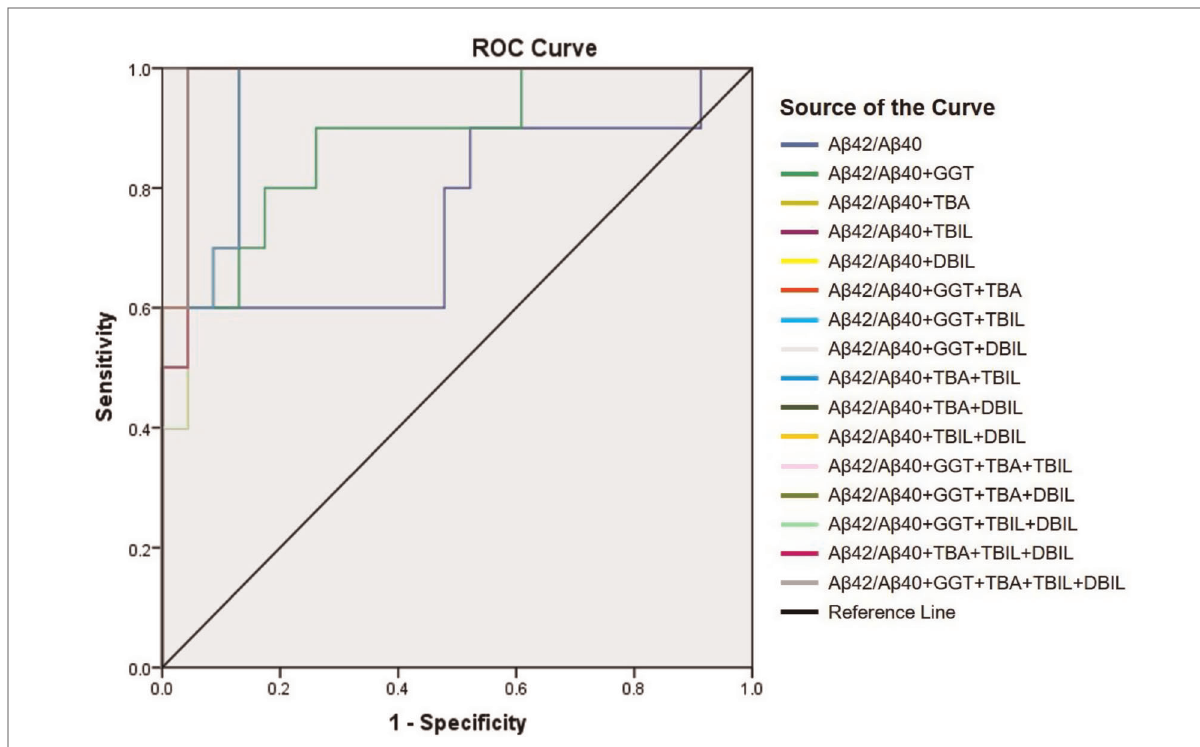
FIGURE 2 Receiver-operating characteristic (ROC) curve of A β 42/A β 40 alone and together with other hepatic function parameters.